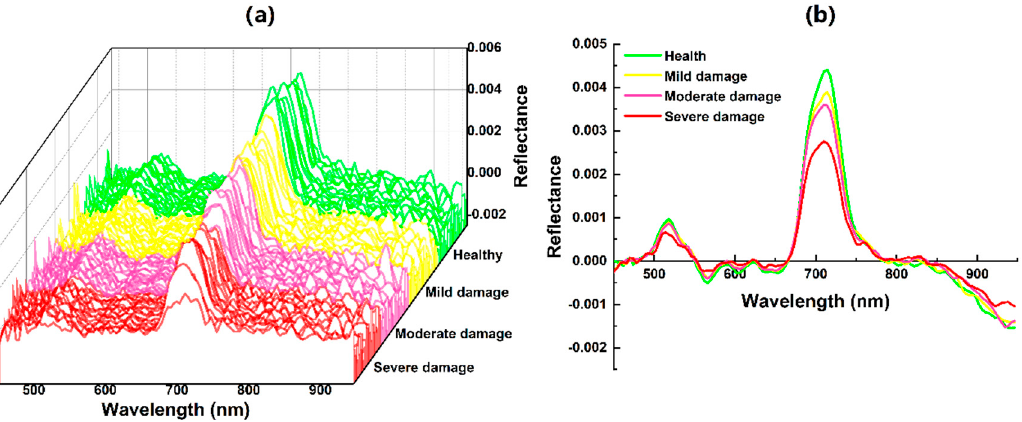
Figure A2. The first derivative curves of different damage degree Pinus yunnanensis canopy by Tomicus. ( a ). the first derivative curves of the canopy spectra; ( b ). the first derivative average curves of the canopy spectra.